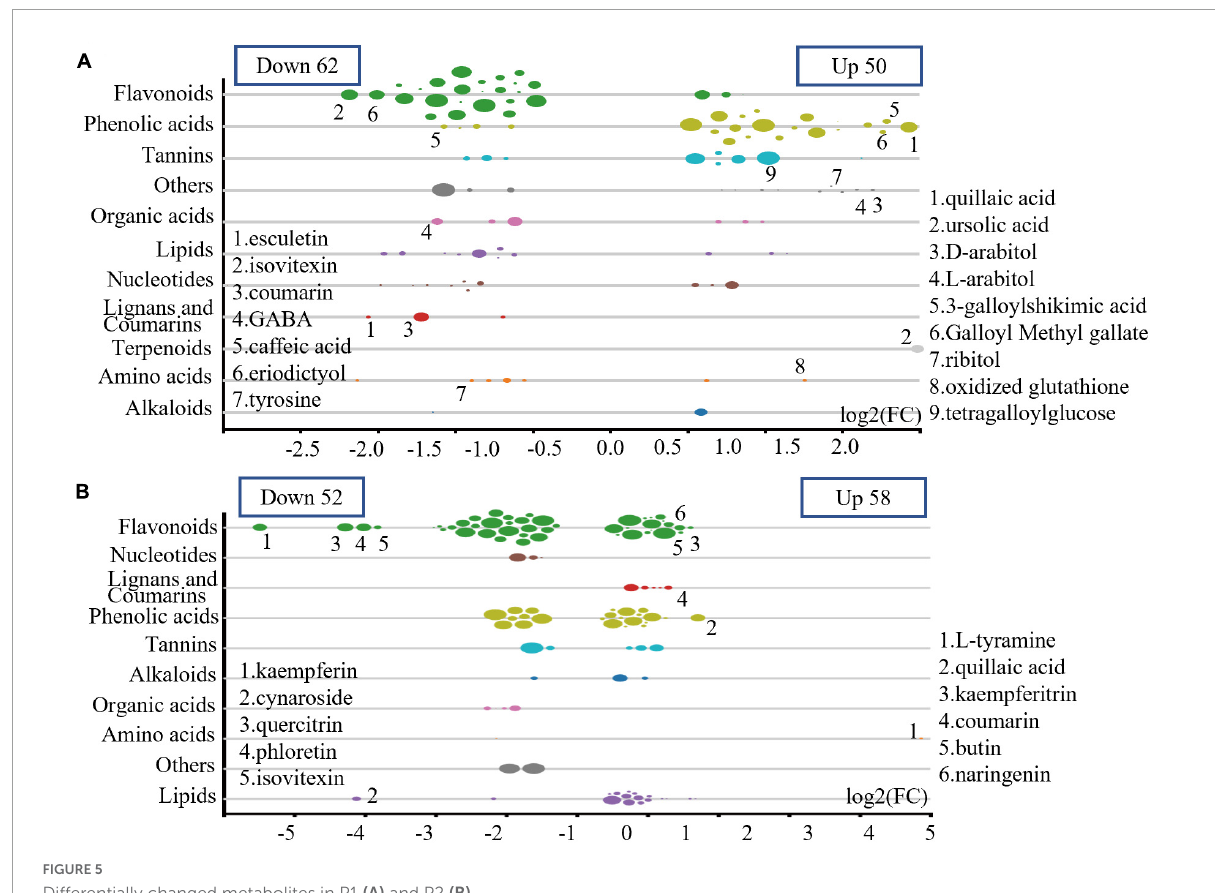
FIGURE5 Differentially changed metabolites in P1 (A) and P2 (B)